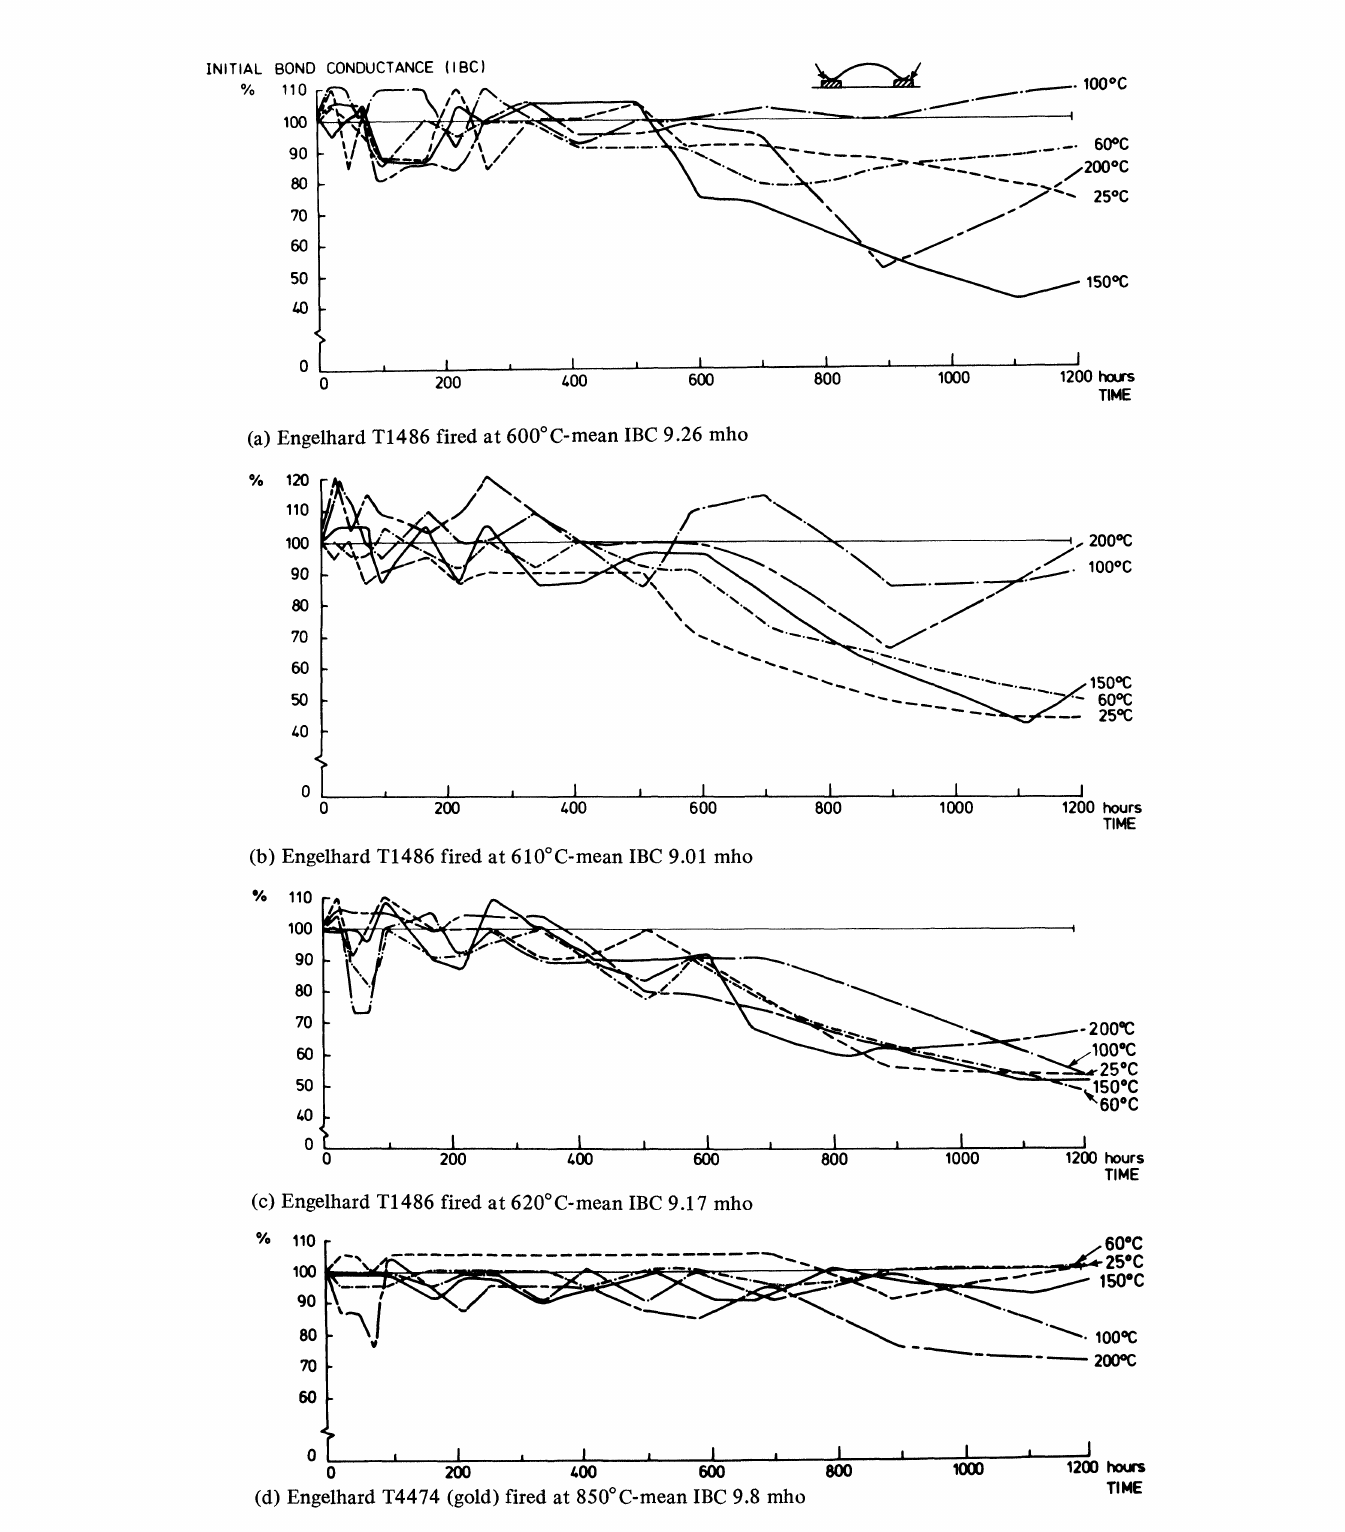
FIGURE 9 Effect of tfiermal soak on the conductance of 25 micron A1/Si wire